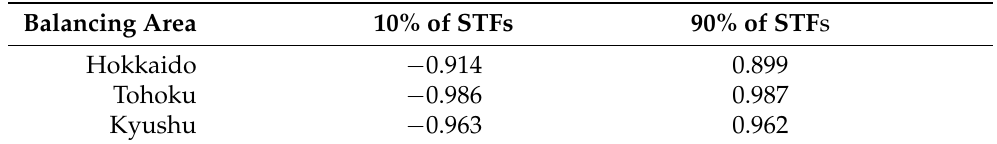
Table 3. Correlation coefficients between the 10th and 90th percentiles of short-term fluctuations (STFs) and average long-term fluctuations in each month for the 2012 fiscal